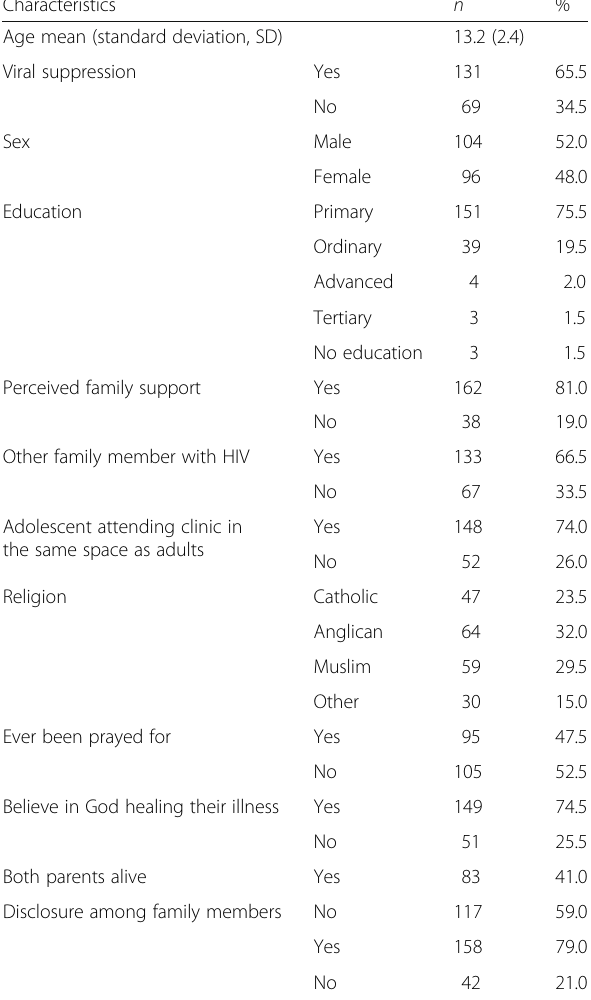
Table 1 Socio-demographic and client-related characteristics